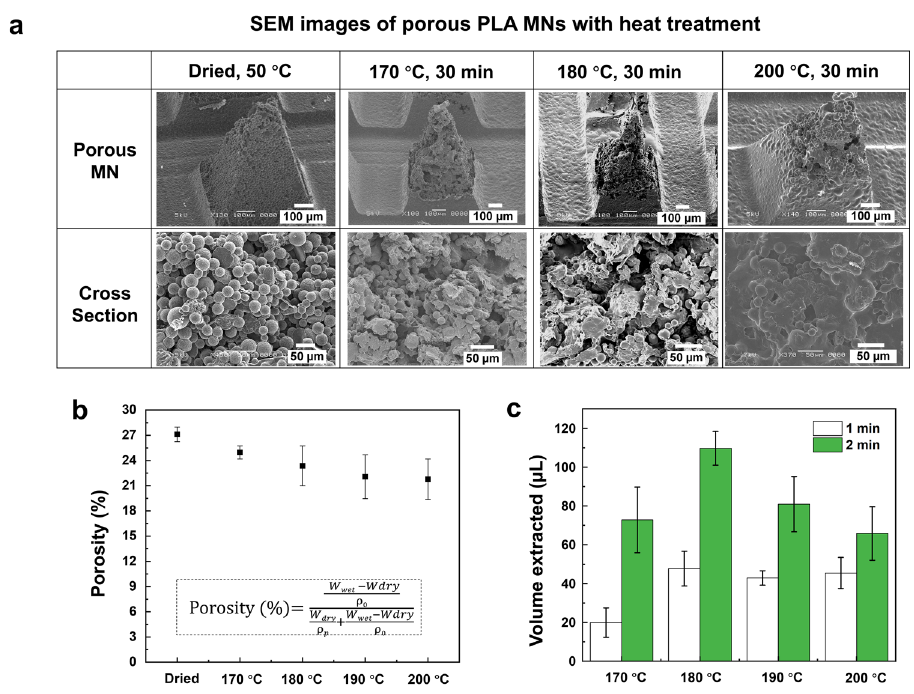
Figure 3. Porous structure and fluid absorption of MNs after heat treatment. ( a ) SEM images of single MN structure and its cross-section. ( b ) Porosity of porous MNs as determined by water imbibition method. ( c ) The absorbed volume of sample fluids from 1% (w/v) agarose gel at 1 min and 2 min (n =